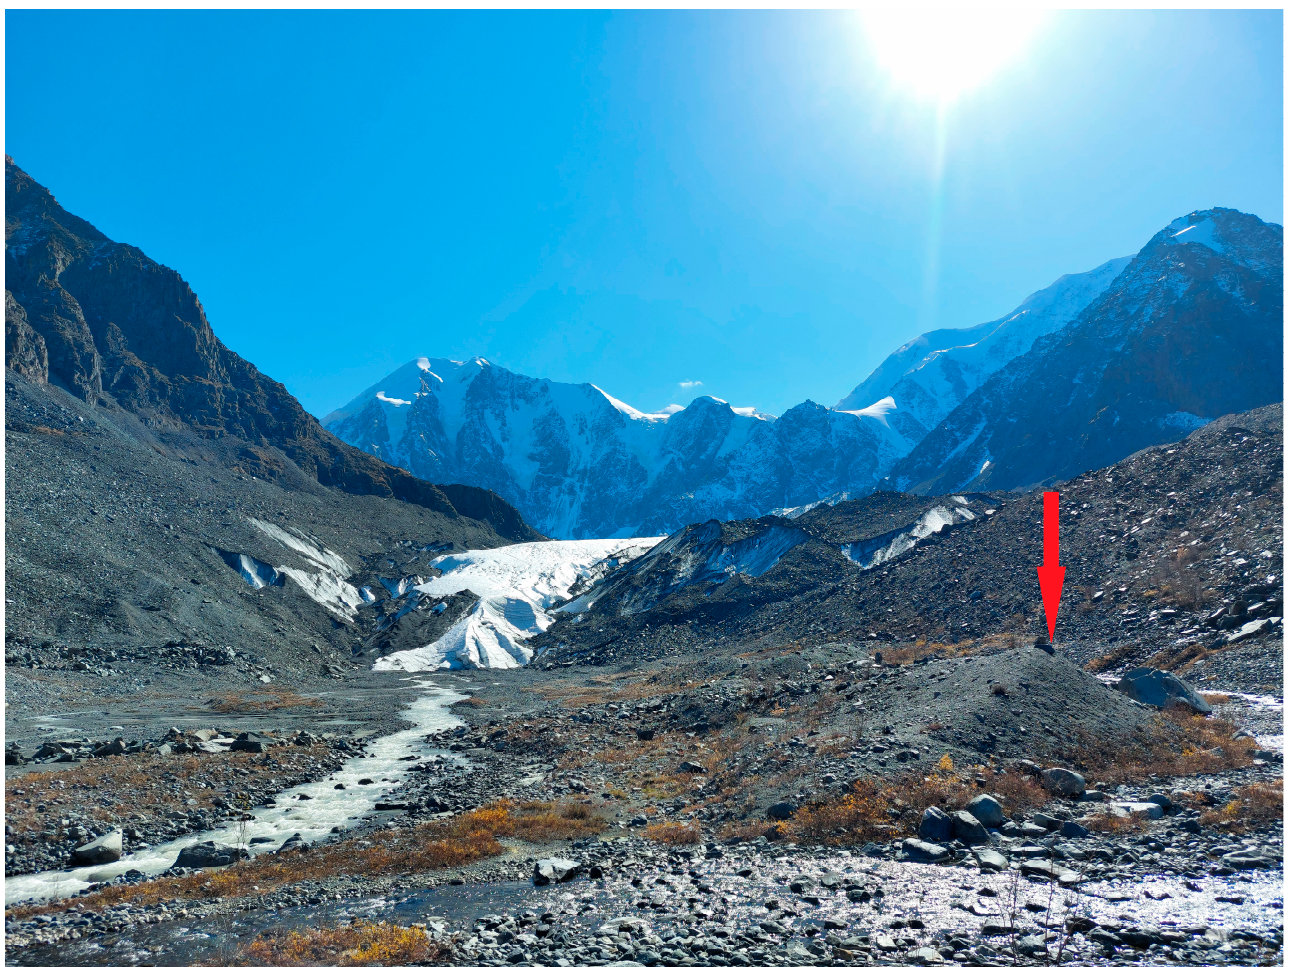
Figure 15. The terminus of the Bolshoi Maashei glacier and the remains of a moraine rampart of 1944–1947 (the nearest plan, red arrow), photo by E. Derkach, taken in 2022.